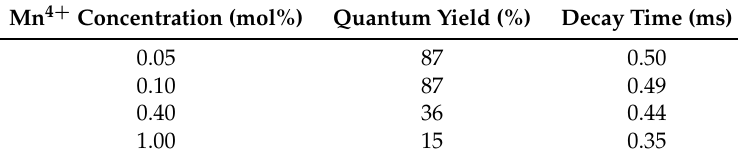
Table 1. Quantum yield and luminescence decay times for various Mn 4 + concentrations at 20 ◦